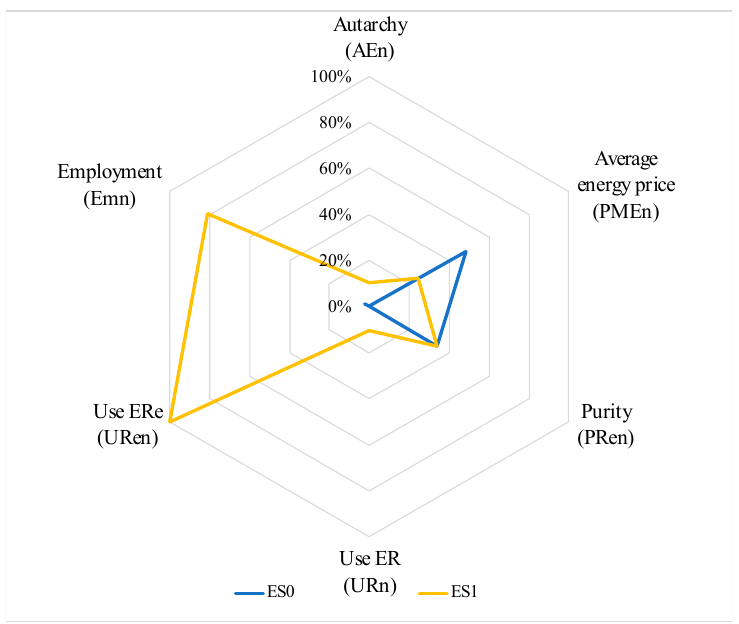
Figure 10. The comparison of sustainability energy indicators.